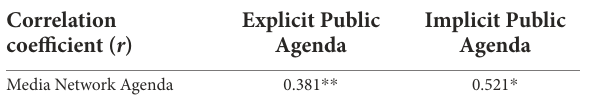
TABLE 3 Effectiveness of network agenda-setting during the COVID-19